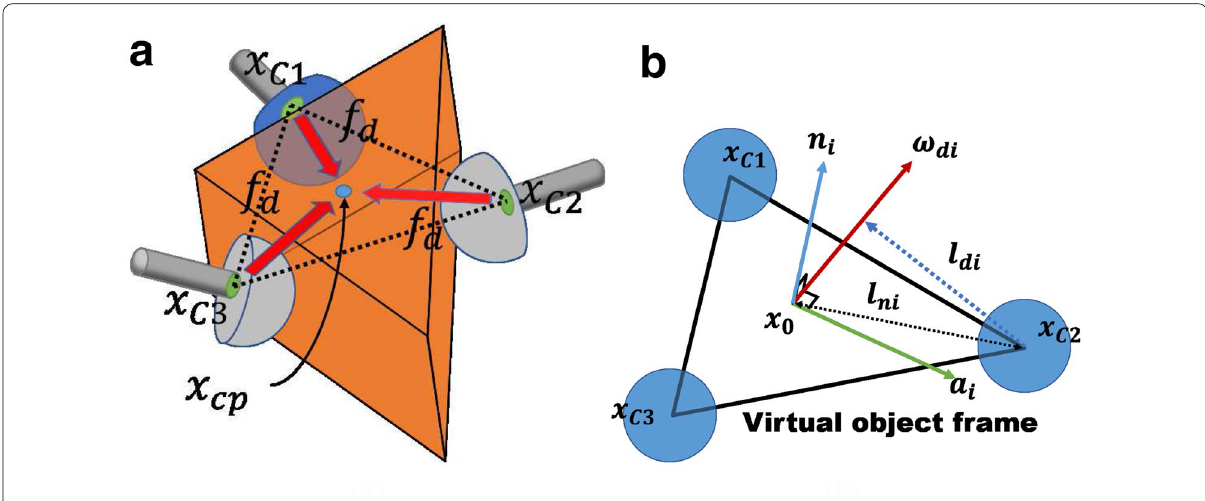
Fig. 15 Concept and component of the object reliably grasping and the object orientation controller: a The reliable grasping controller forces each fingertip to the center of the triangle created by the fingertip position. b Each finger applies torque around one rotational axis in the object orientation